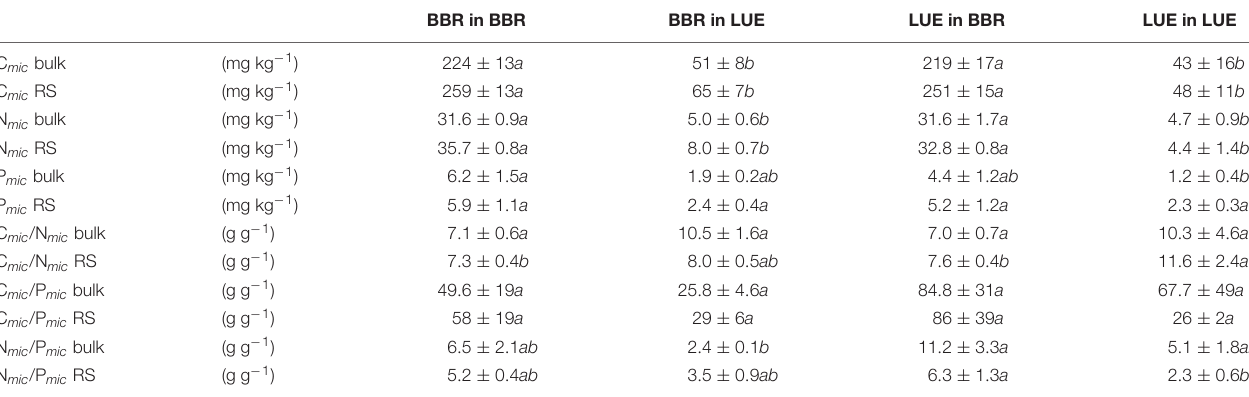
TABLE 5 | Soil microbial biomass C, N, and P concentrations (per dry weight) in the bulk soil (bulk) and the rhizosphere (RS), as well as ratios in the rhizosphere, as measured during the second growing season in a rhizobox experiment with beech ( Fagus sylvatica L.) saplings originating from the sites Bad Brückenau (BBR) and Unterlüss (LUE).